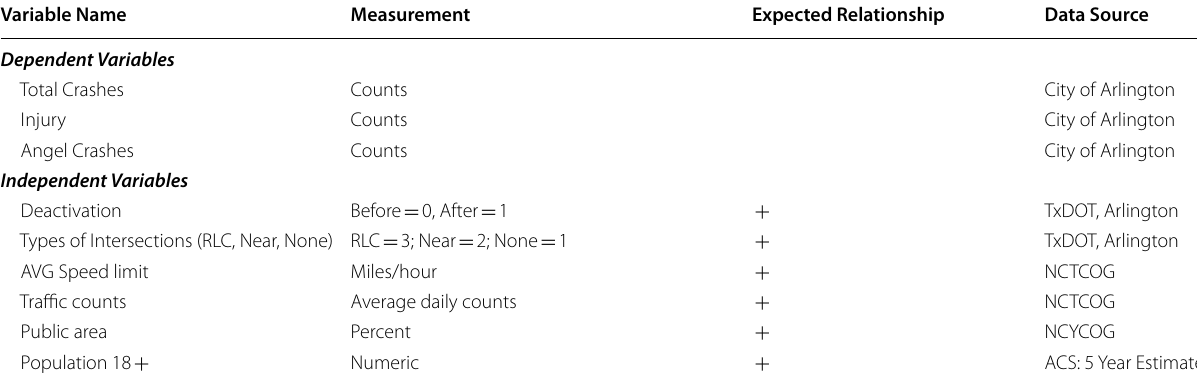
Table 1 Research variables, measurements, hypotheses, and data